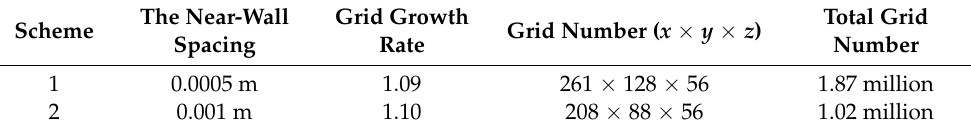
Table 2. Settings of the two grid size levels.